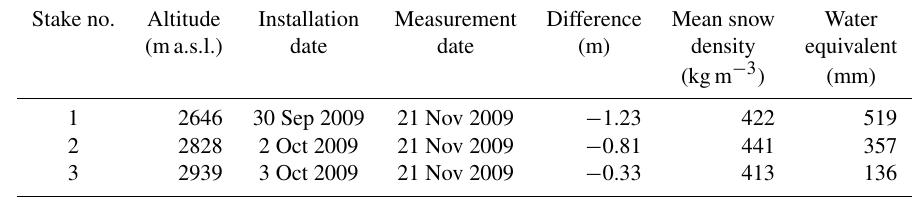
Table 1. Stake ablation measurements.